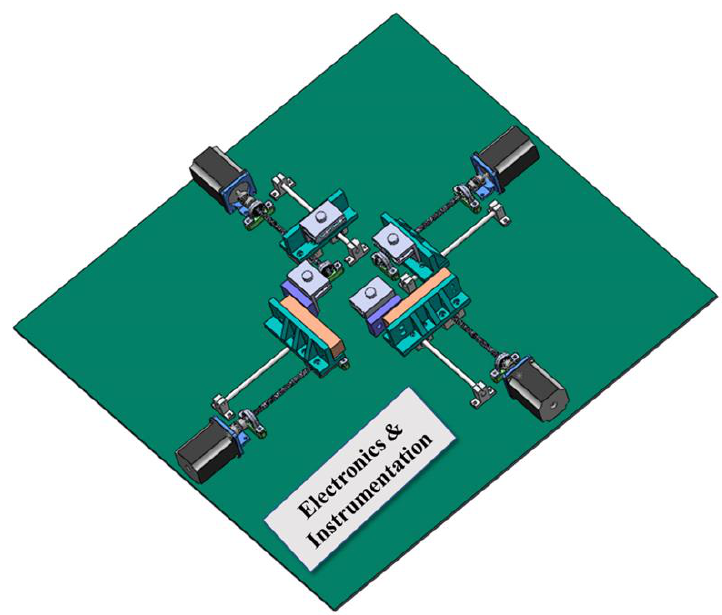
Figure 3. Three-dimensional schematic diagram of planer biaxial